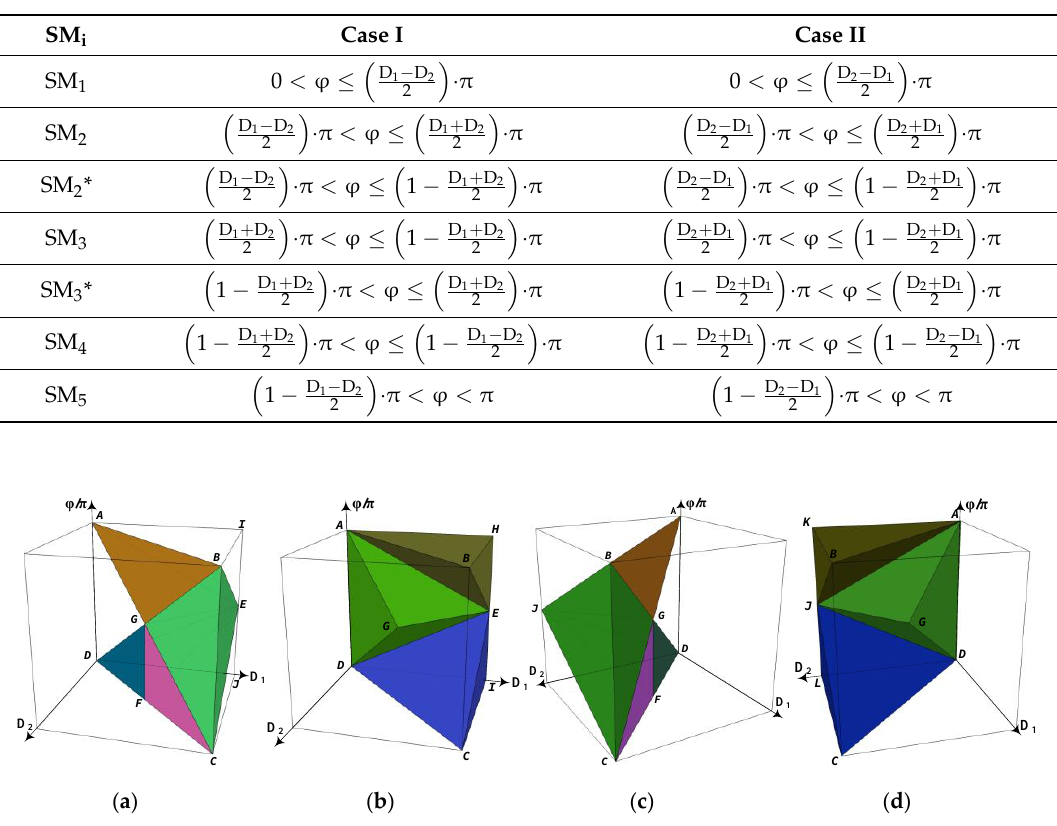
Figure 6. Switching modes. Case I: ( a ) SM 2 , SM 2 *, SM 3 *, and SM 4 ; ( b ) SM 1 , SM 3 and SM 5 ; Case II: ( c ) SM 2 , SM 2 *, SM 3 *, and SM 4 ; and ( d ) SM 1 , SM 3 and SM 5 .